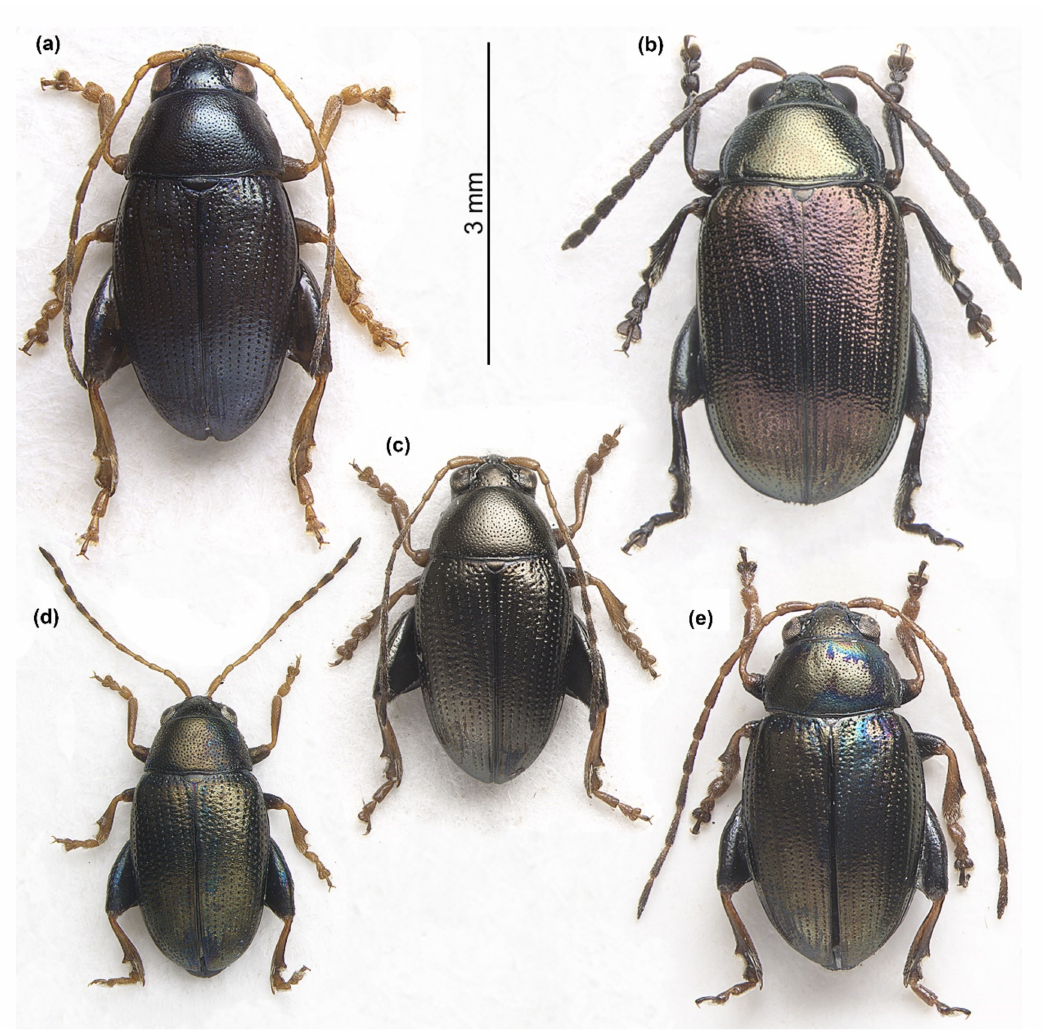
Figure 1. Habitus of the target flea beetle species of the genus Chaetocnema Stephens, whose climate—occurrence relationships and associations with vegetation groups in South Africa were analyzed; ( a ) Chaetocnema gahani Jacoby, 1897; ( b ) C. natalensis Baly, 1877; ( c ) C. darwini Bryant, 1928; ( d ) C. danielssoni Biondi & D’Alessandro, 2006; ( e ) C. brincki (Bechyn é ,